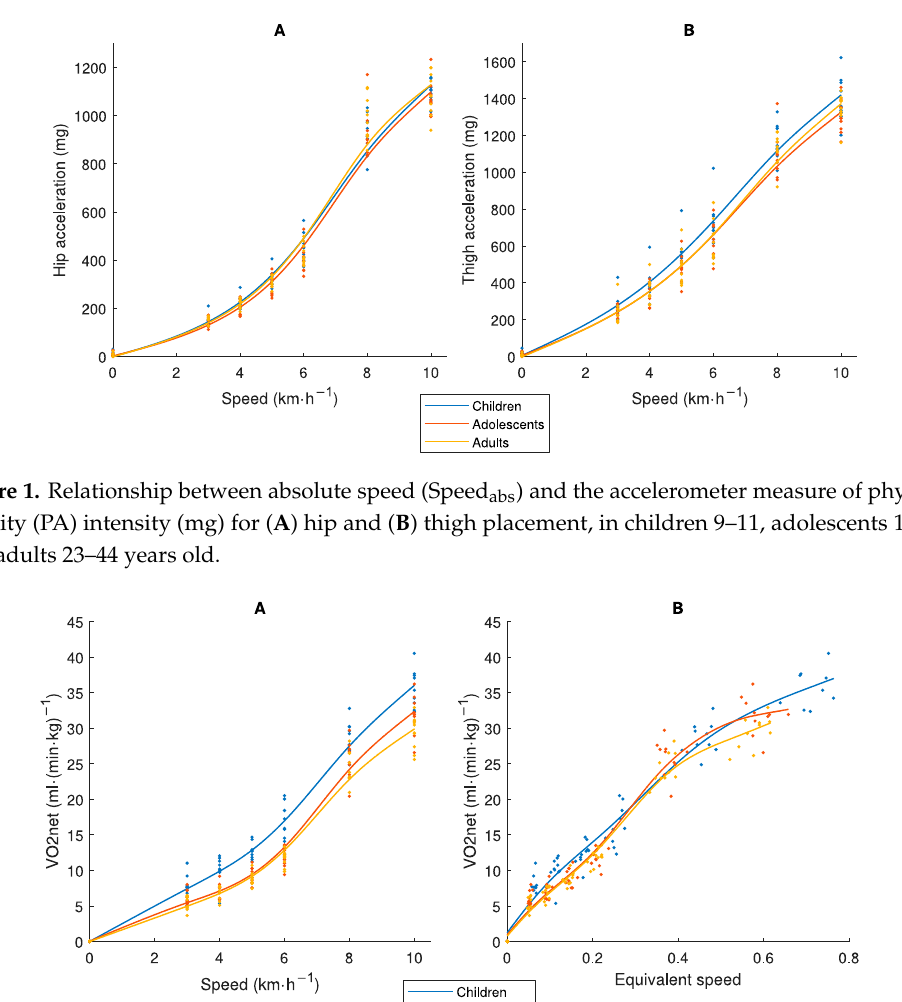
Figure 2. Relationship between ( A ) Speed abs or ( B ) equivalent speed (Speed eq ) and net oxygen consumption (VO 2net ), in children 9–11, adolescents 14–16 and adults 23–44 years old.